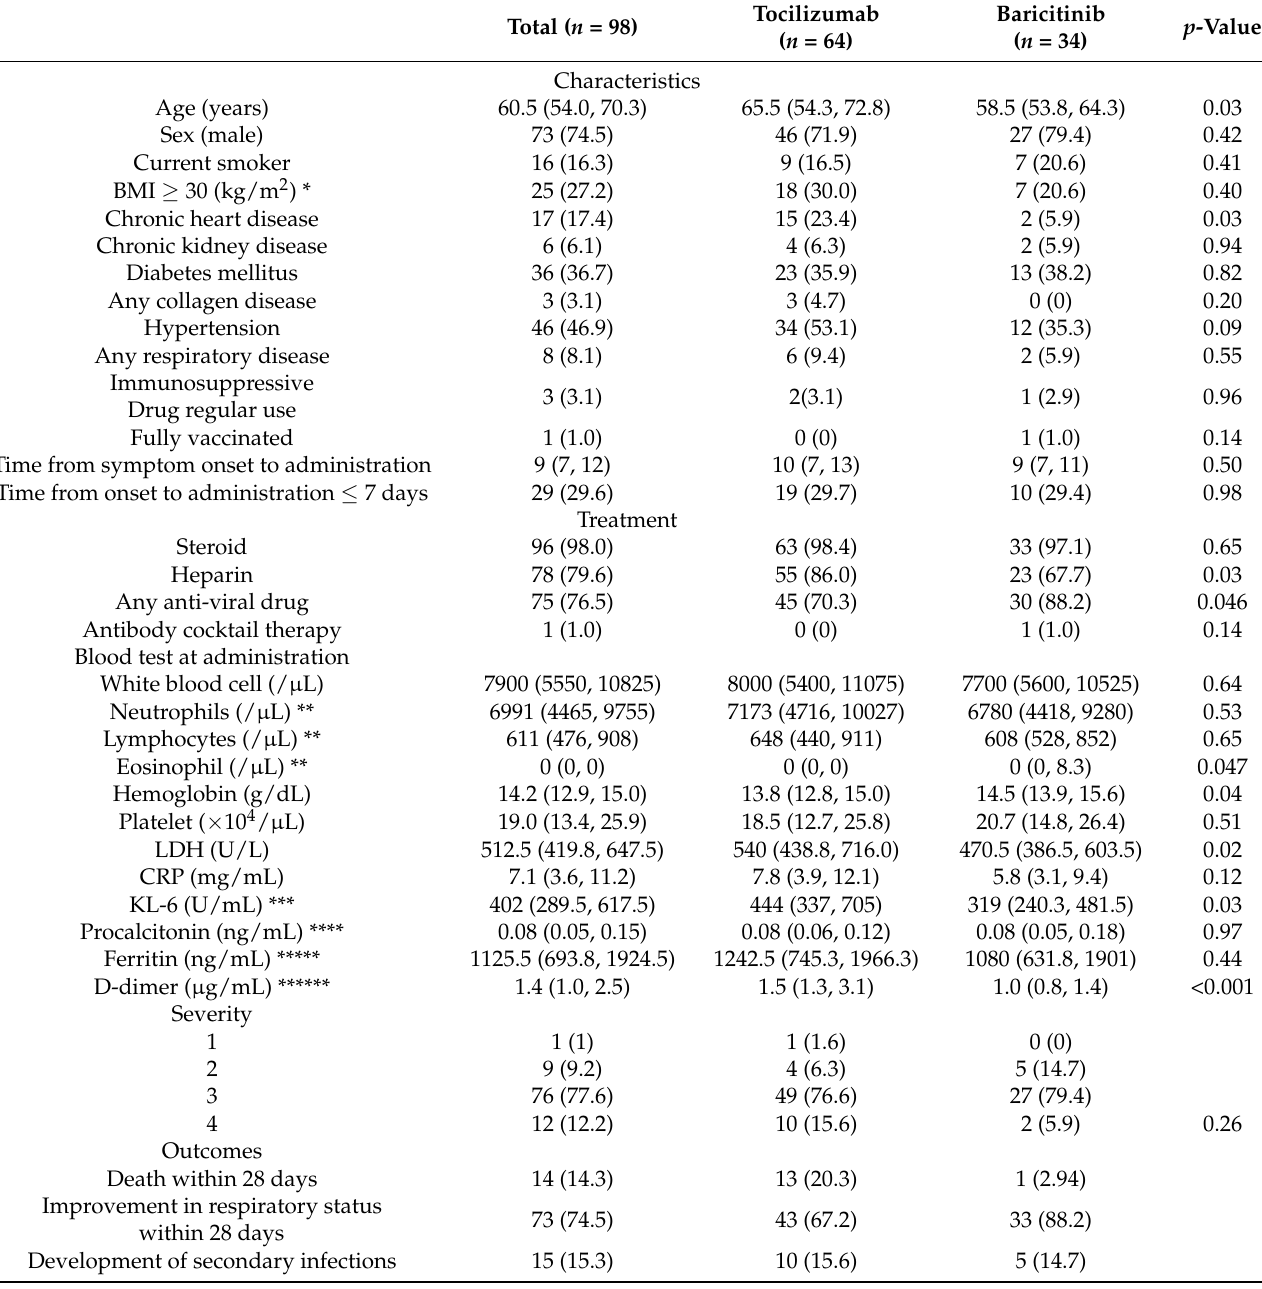
Table 1. Comparison between baseline characteristics of tocilizumab and baricitinib